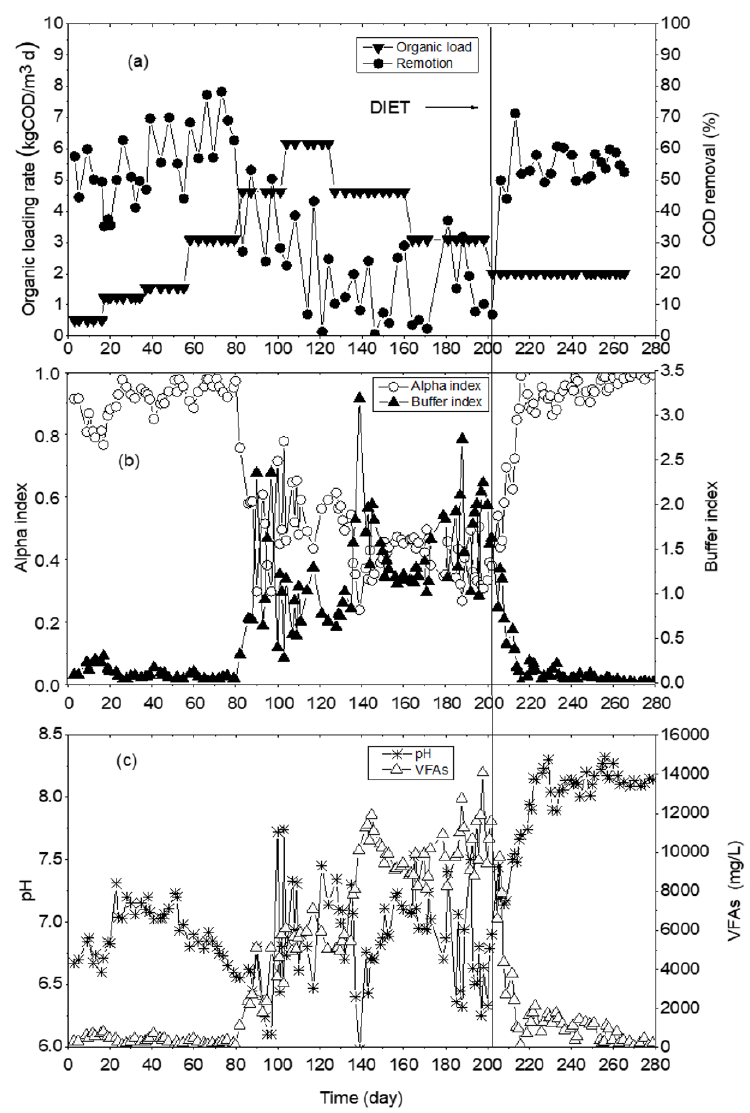
Figure 3. Upflow anaerobic sludge blanket acclimatization: ( a ) organic loading rate and chemical oxygen demand removal, ( b ) alpha and bu ff er indices, ( c ) volatile fatty acids and